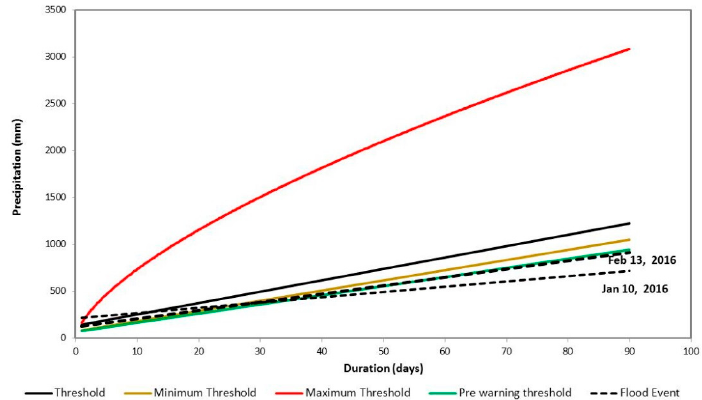
Figure 6. Thresholds of accumulated precipitation with different lengths and subsequent flood events: 10 January and 13 February 2016. Threshold of flood events ( black ); maximum threshold ( red ); minimum threshold ( yellow ); and pre ‐ warning threshold ( green ). The broken lines indicate the flood events.